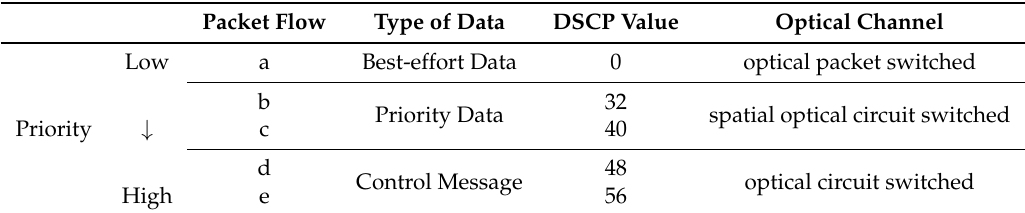
Table 1. Mapping table for data types, differentiated services code point (DSCP) values of IP packets and optical channels in each IP packet